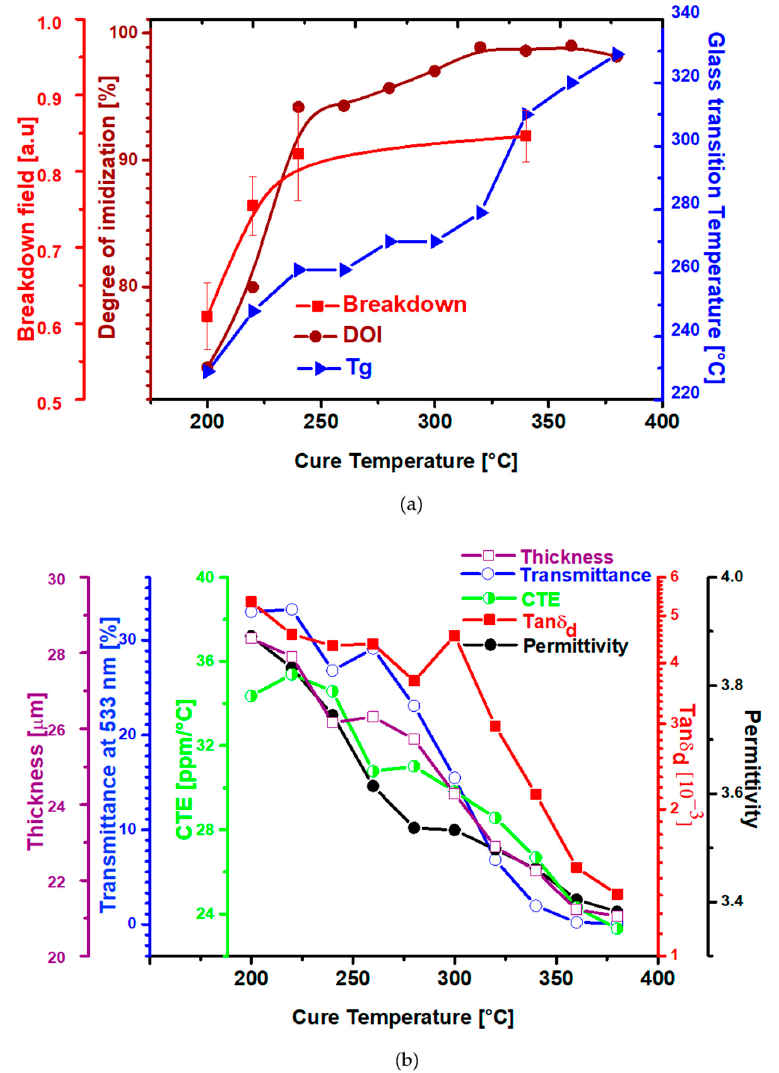
Figure 6. Universal plot of the main physical changes in PMDA-ODA polyimide films over the thermal imidization process: ( a ) DOI, T g , E BR , and ( b ) thickness, UV–vis transmittance, CTE, tan δ d , and ɛ ’.